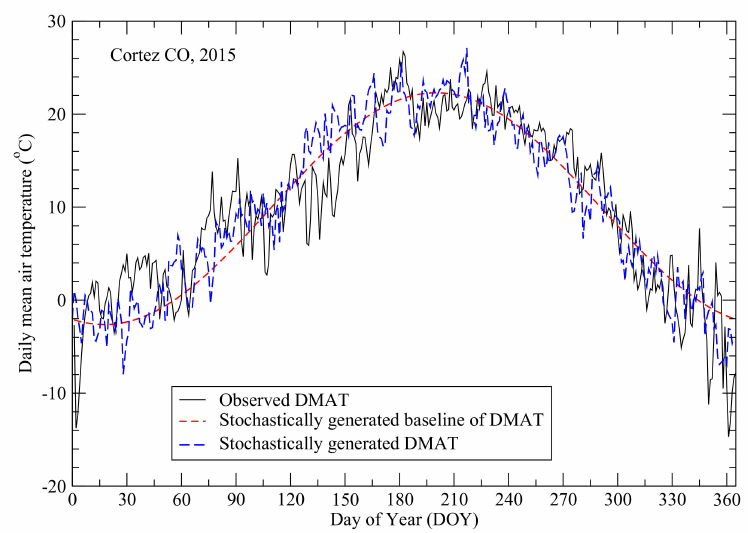
Figure 6. Observed (black) and stochastically generated (blue) daily mean air temperatures of year 2015 at the Cortez station. The red curve is the stochastically generated baseline of daily mean air temperatures of year 2015 at the Cortez